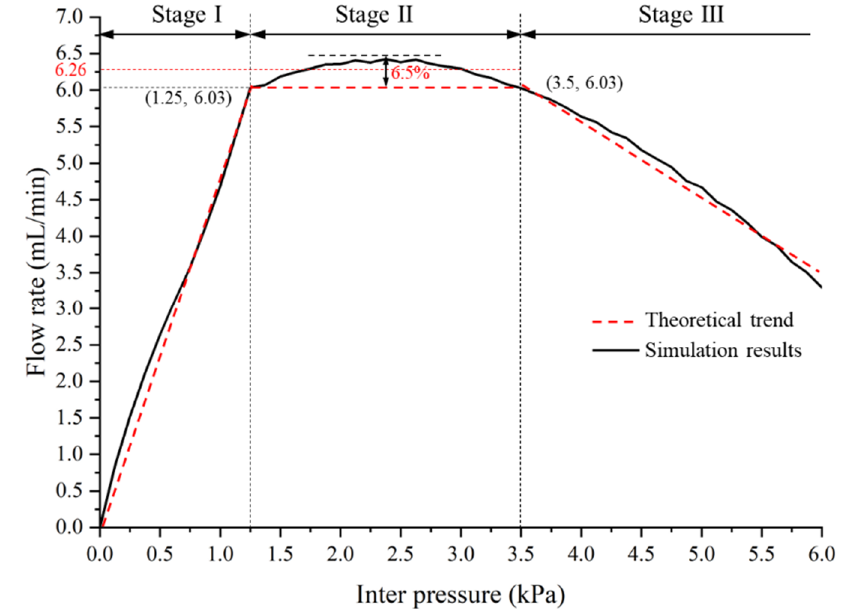
Figure 6. Flow rate of the MPV under varied inlet pressures.